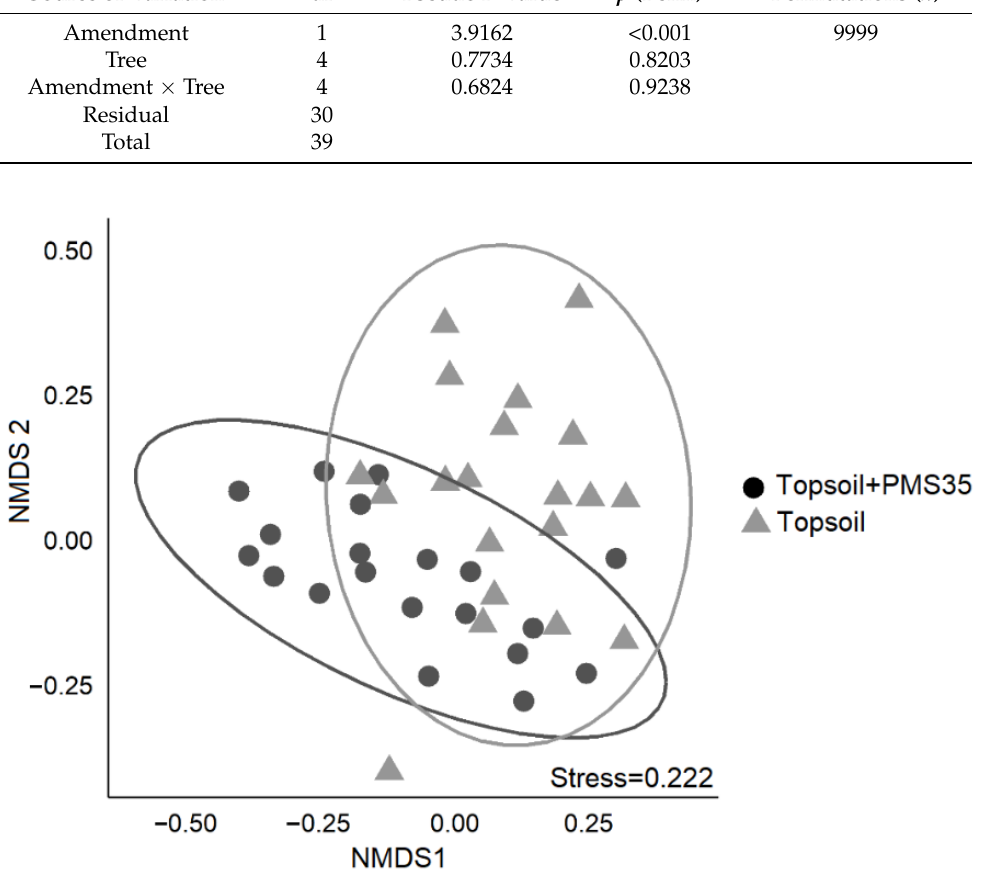
Figure 2. Non-metric multidimensional scaling (NMDS) representation of community structure in relation to the effect of amendment application (topsoil+PMS35 and topsoil) at the Niobec site. Ellipses represent 95% confidence